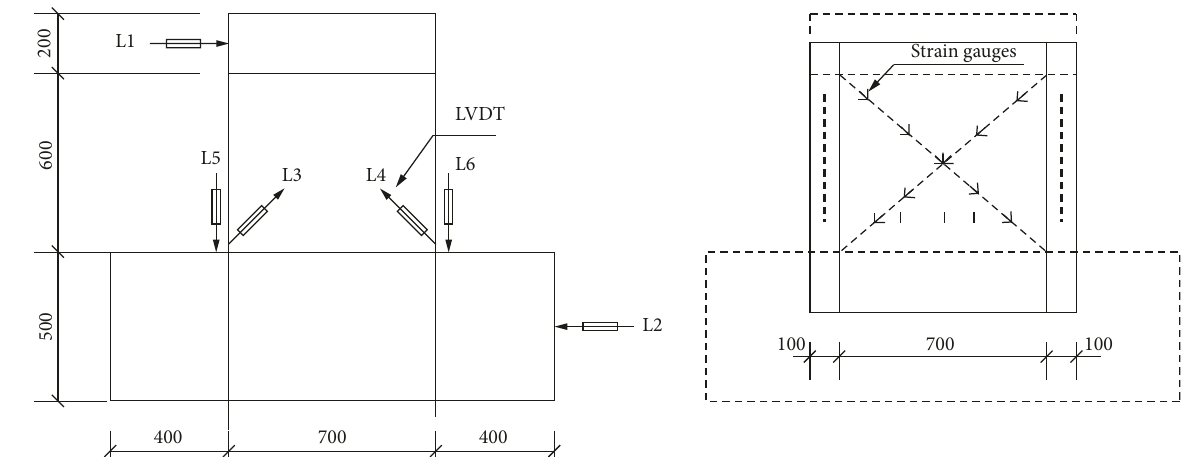
Figure 4: Displacement transducers arrangement.